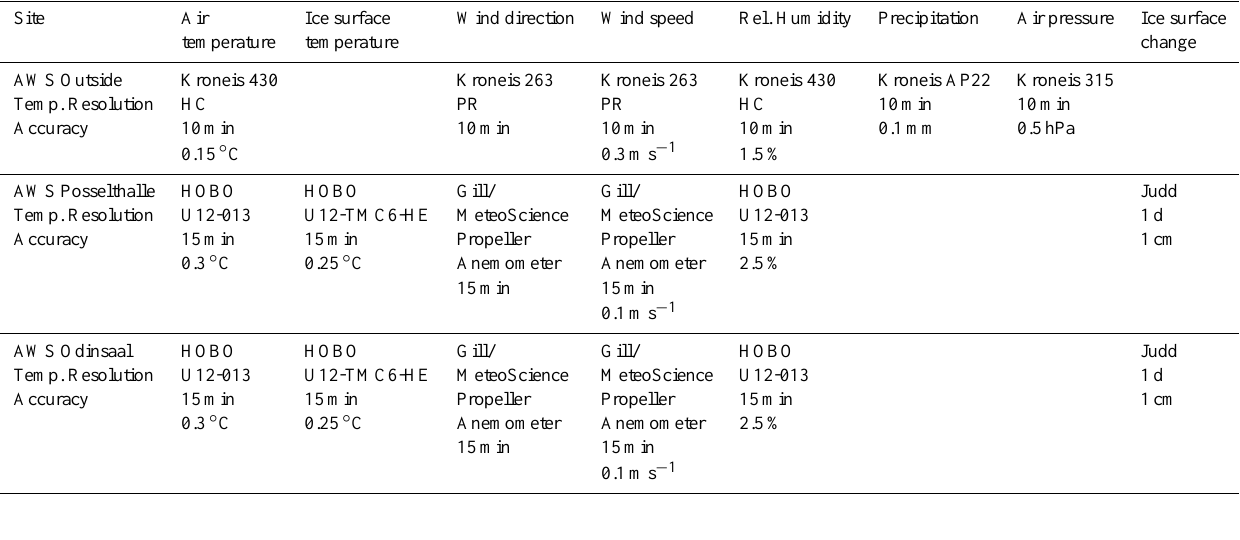
Table 1. List of meta-information on meteorological sensors used in the study.